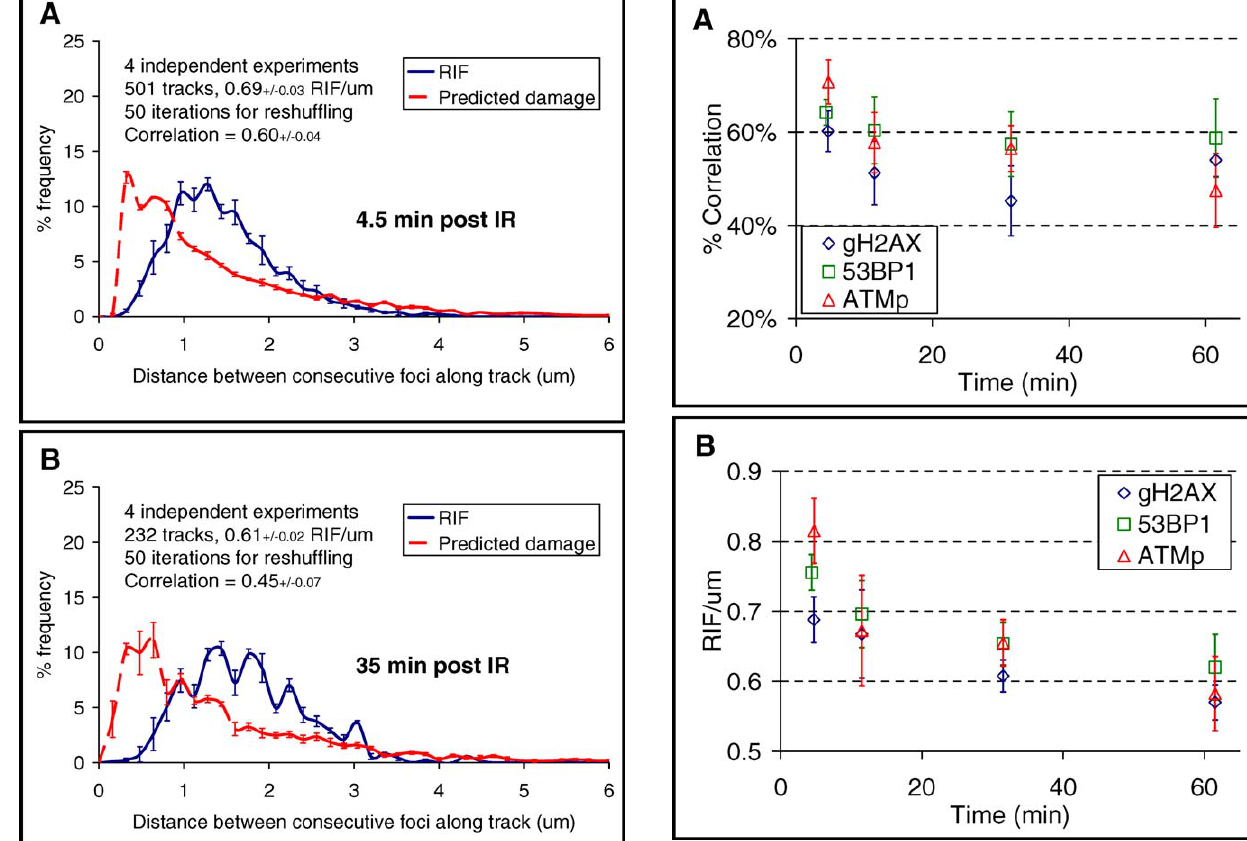
Figure 5. Spatial Foci Pattern Increasingly Deviates from Prediction Following 1 Gy of 1 GeV/amu Fe Exposure (A) Plots the correlation between theoretical and experimental distributions of distances between consecutive foci along Fe tracks over the first hour following exposure to radiation. All DNA damage markers used (i.e., c H2AX, ATMp, 53BP1) show the same loss of correlation to randomness over time. (B) Shows the corresponding foci frequencies, depicting a rapidly decreasing curve indicative of DNA repair. doi:10.1371/journal.pcbi.0030155.g005 values. The ratio of Rdna ( R ) and Rgrad ( Rg ) between simulated pRIF (indexed 1) and reshuffled pRIF (indexed 2) are shown in Table 2 (i.e., R1/R2 and Rg1/Rg2 ). These ratios are very close to 1, indicating a foci pattern for pRIF that matches the expected random distribution of DNA damage.